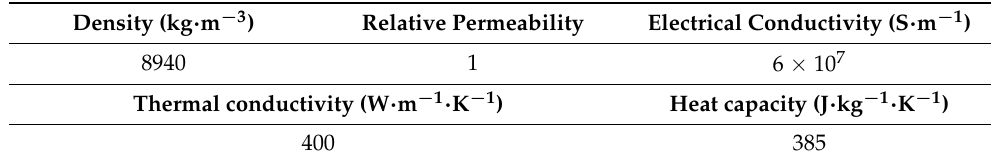
Table 3. The material properties of copper.